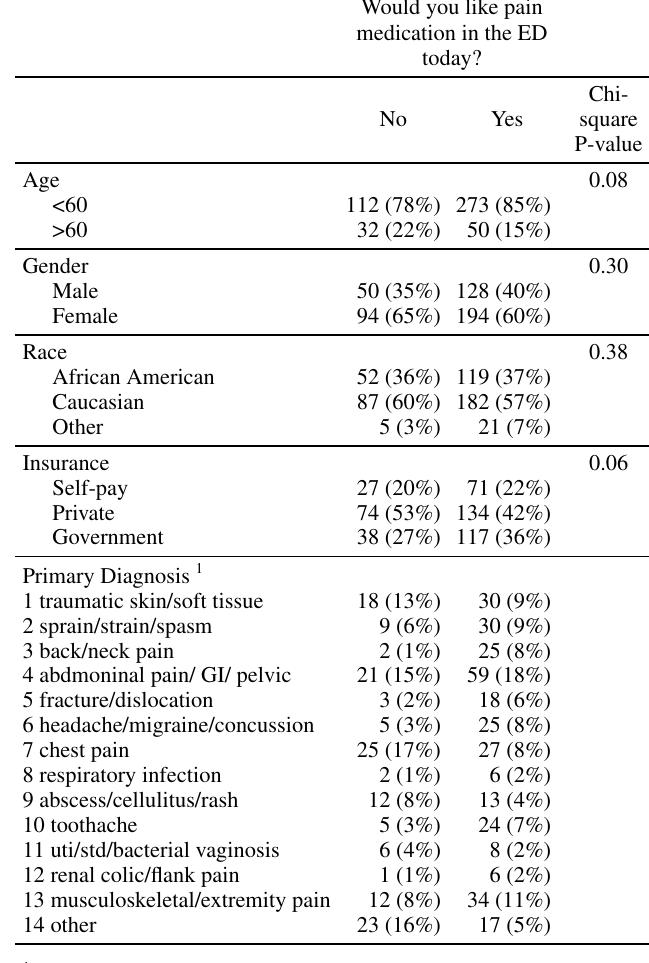
Table 3. Association between Desire for Pain Medication and Patient